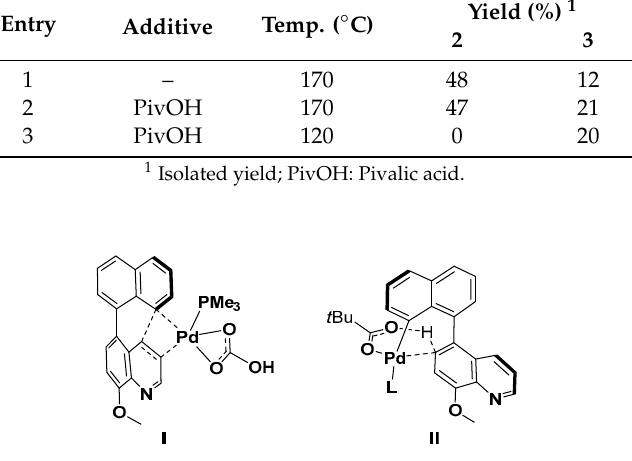
Figure 2. Transition-states I and II for the formation of 2 and 3 via Heck-type and concerted metalation–deprotonation (CMD) pathways, respectively.